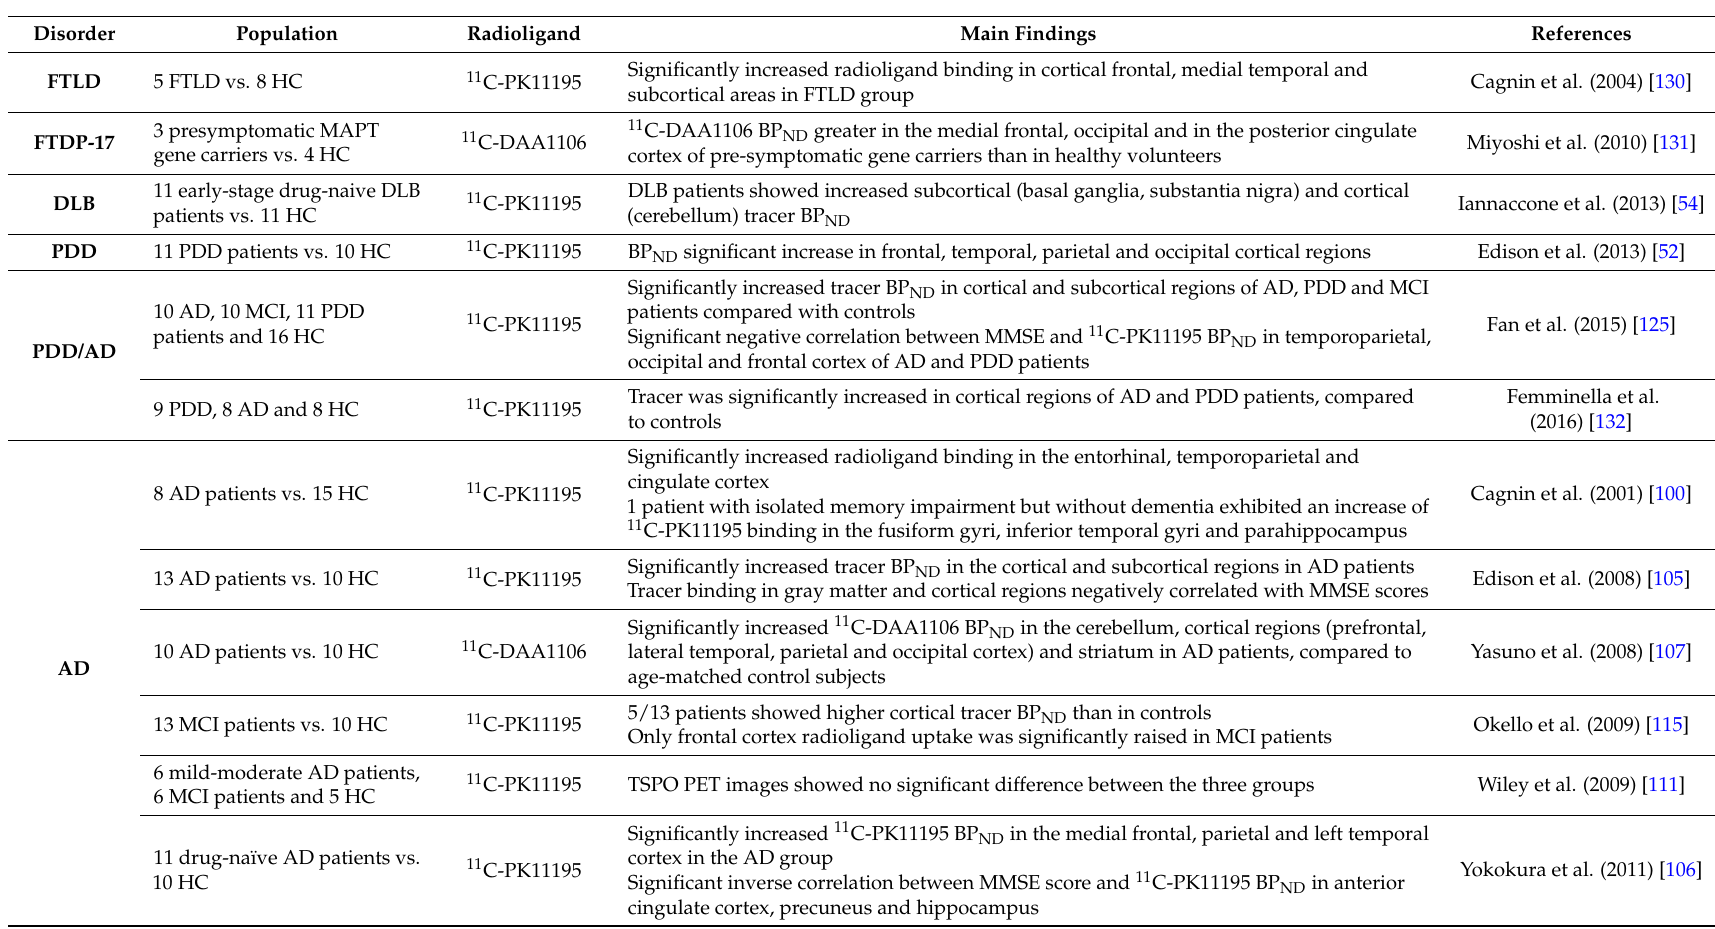
Table 4. PET imaging studies assessing TSPO tracers in